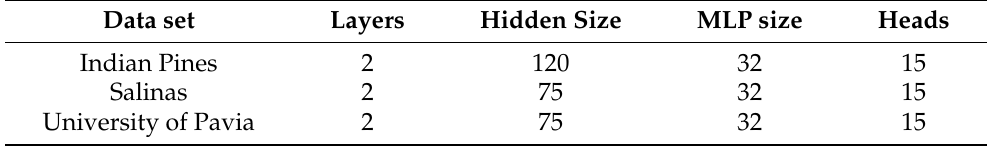
Table 4. Configuration of our proposed model variants.